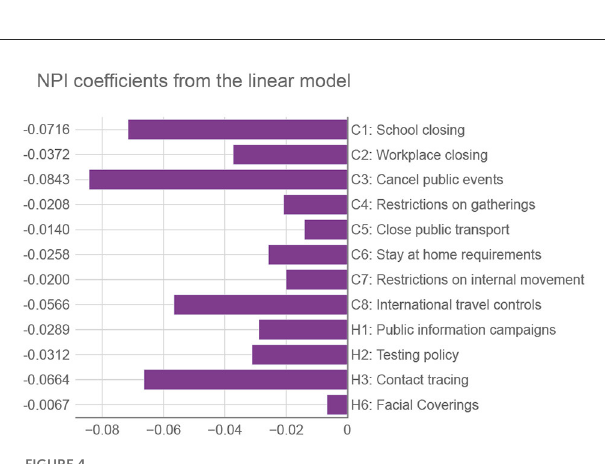
FIGURE4 Coefficients from the linear model corresponding to OxNPIs. We use the terminology of Oxford’s COVID-19 Government Response Tracker (12), with containment (C) and health (H) categories. Relative values of NPIs can signify their importance for reducing the number of infections—the larger the negative value, the more they suppress the infection